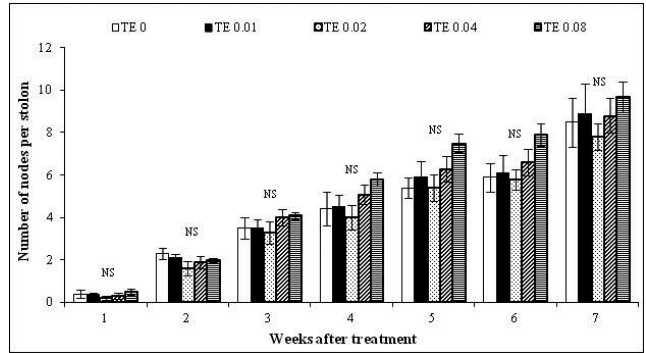
Fig. 2 - Number of nodes per stolon in Patriot bermudagrass treated with different rates of TE (kg a.i. ha -1 ). Within the same week, different letters show significantly different values for P≤0.05 (LSD test). Vertical bars show se of the means (n=5); ns= not